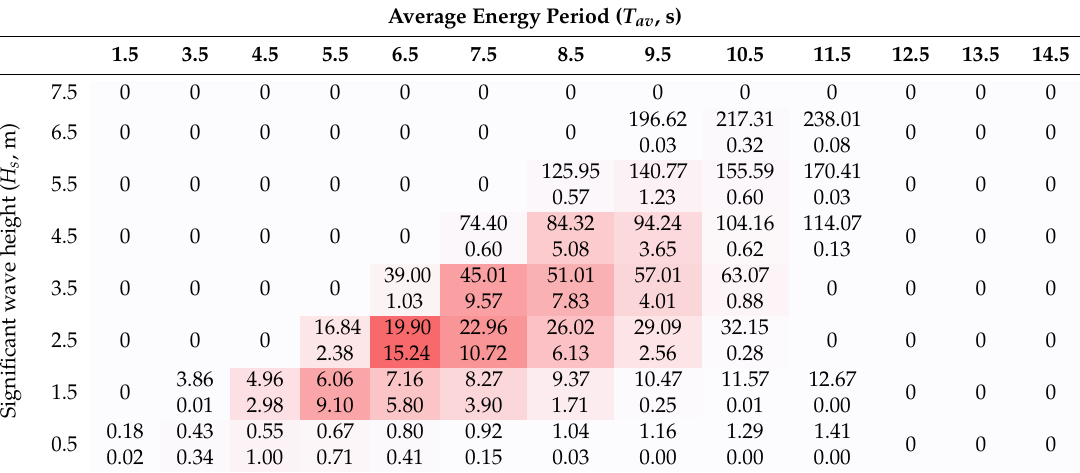
Table 6. Wave-power levels (upper data, kW / m) and energy distribution probabilities (underlying data, %).